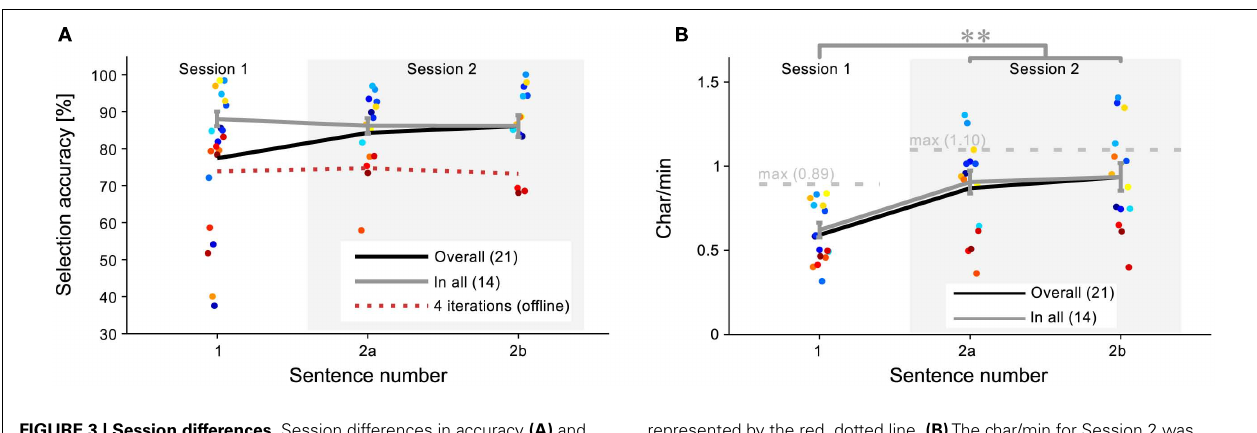
FIGURE 3 | Session differences. Session differences in accuracy (A) and char/min (B) are plotted for all subjects.The black line represents the mean of all subjects in a session and the gray line represents the mean of the 14 subjects that succeeded on all three sentences. (A) No significant difference was found between sessions in the accuracy. No learning effect was found even when the number of iterations was reduced to four, as